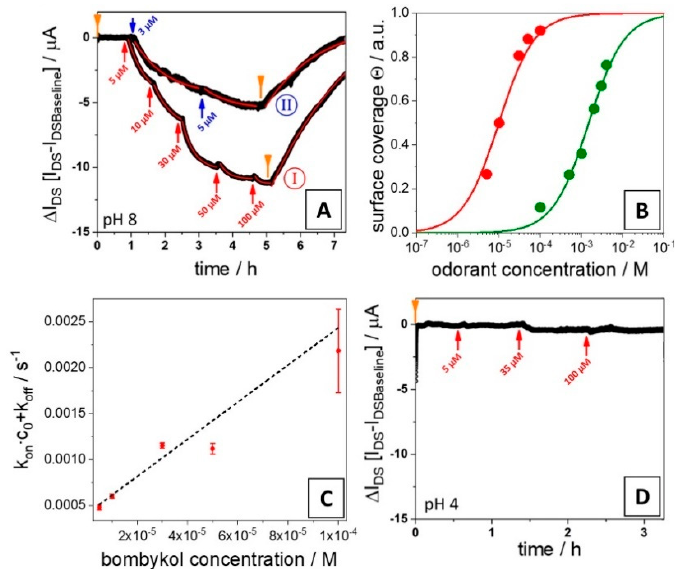
Figure 2. ( A ) Global analysis of the binding of bombykol (I) and bombykal (II) to a BmorPBP1-functionalized reduced graphene oxide field-effect transistors (rGO-FET) device, monitoring the association on the sensor surface for increasing analyte concentrations (3 µ M to 100 µ M) at pH 8, and the dissociation upon rising the flow cell with pure buffer; the red and the blue arrows indicate the addition of analyte solution of the given concentration, the orange ones mark the switching in the flow cell to pure buffer. The red curves in the data traces are the kinetic fits to the time-dependent changes, Δ I DS , of the source–drain current: with increasing concentration, this yields the binding rate constant, k on c 0 + k off , from the fit to the rinsing step one obtains k off alone. ( B ) Langmuir isotherms, i.e., coverage, as a function of the analyte solution concentration, c 0 : red full circles are the data points from bombykol (I) in ( A ), green full circles are from a corresponding measurement with 2-isobutyl-3-methoxypyrazine. The S-shaped curves are fits to the data; K d -values thus obtained, K d = 9.8 µ M for bombykol, and 2.8 mM for 2-isobutyl-3-methoxypyrazine, respectively, are also summarized in Table 1. ( C ) k on c 0 + k off values from the bombykol kinetic fits in A (I) as a function of the solution concentration; the slope is a linear fit to the data (according to Equation (2)) with k on = 20 M − 1 s − 1 ; together with k off = 9.4 10 − 5 s − 1 from the dissociation curve, one obtains a kinetically-determined dissociation constant of K d = 4.7 µ M, in very good agreement with the value from the titration experiment in ( B ). ( D ) ∆ I DS , monitored as a function of time after the addition of bombykol solutions of increasing concentration at pH 4; arrows as in ( A